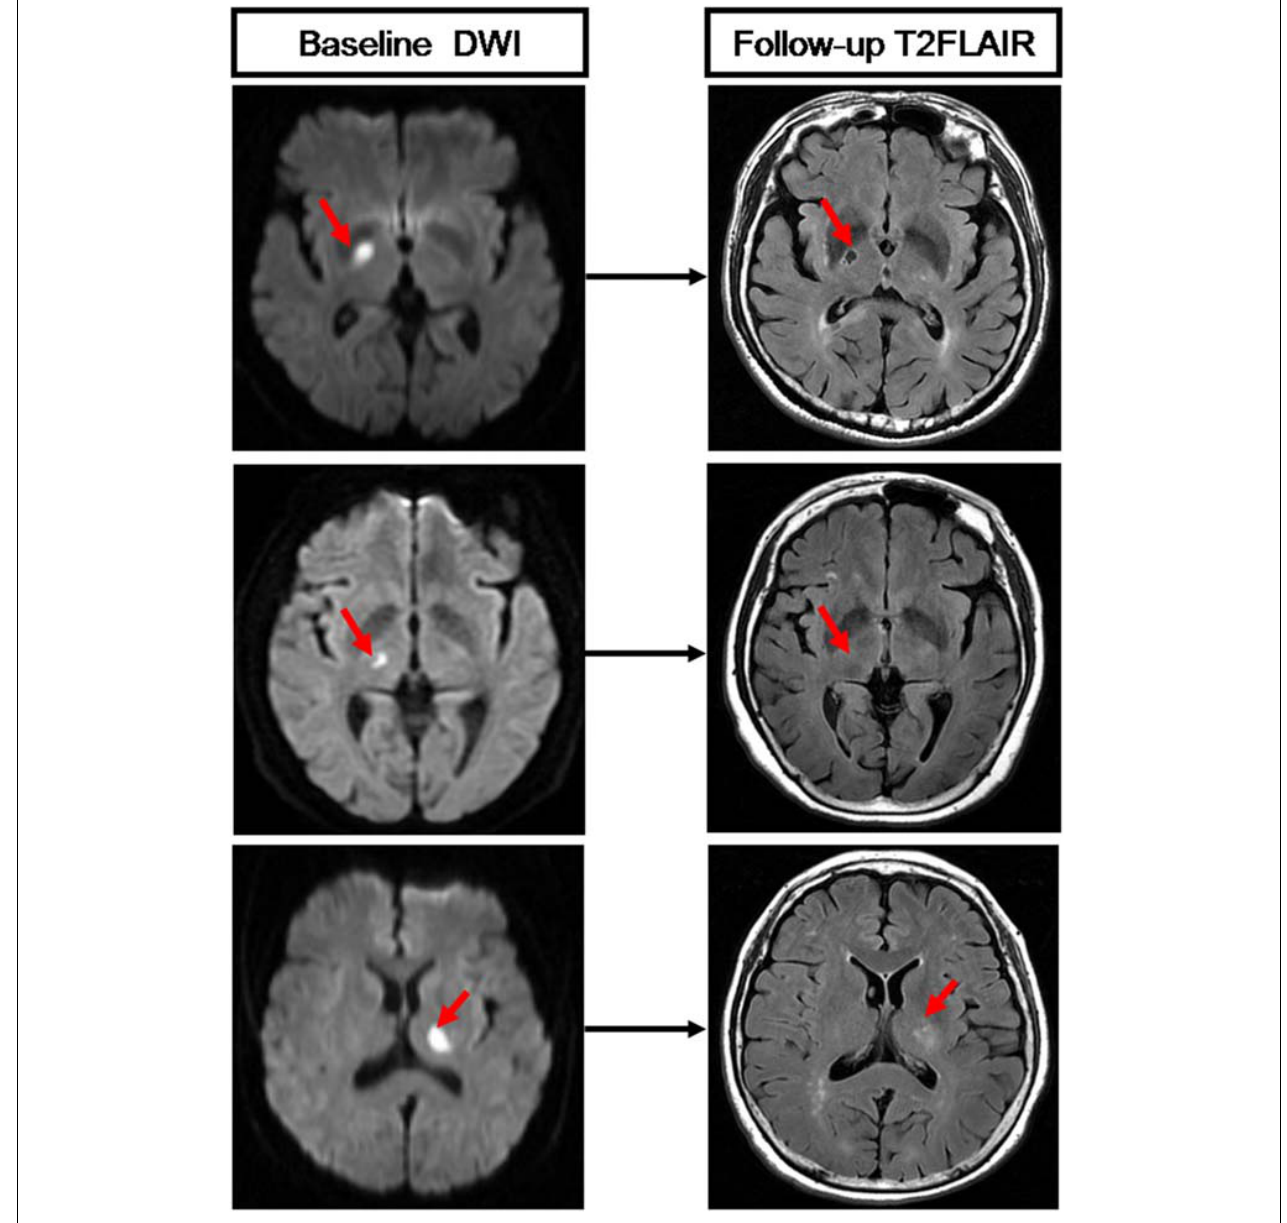
FIGURE 4 | Three RSSIs show different evolution patterns. The top row shows an RSSI (red arrow) has evolved into a lacune on follow-up T2 FLAIR. The medium row shows an RSSI (red arrow) has disappeared on follow-up T2 FLAIR. The bottom row shows an RSSI (red arrow) that remained as white matter hyperintensities on follow-up T2